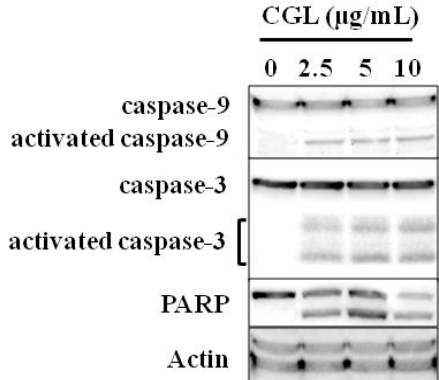
Figure 7. Cell signaling in Raji cells treated with CGL shown by western blotting. Figure was modified from